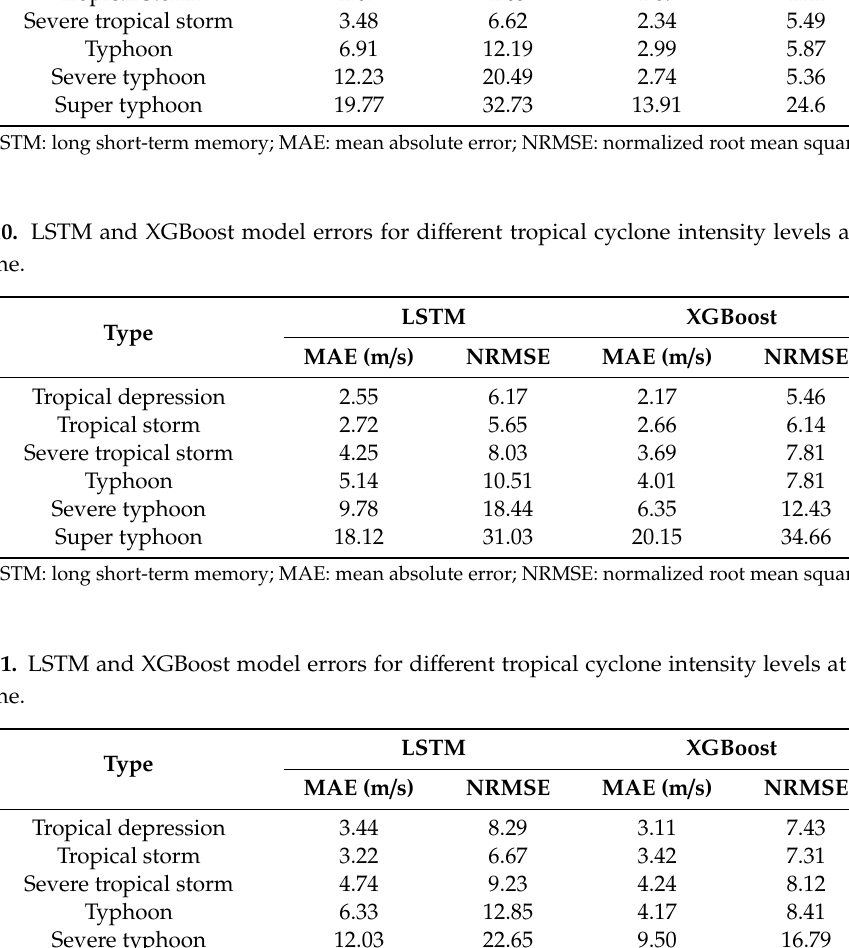
Table 9. LSTM and XGBoost model errors for di ff erent tropical cyclone intensity levels at a 6 h lead time. LSTM XGBoost Type MAE (m / s) NRMSE MAE (m / s) NRMSE Tropical depression 1.56 3.10